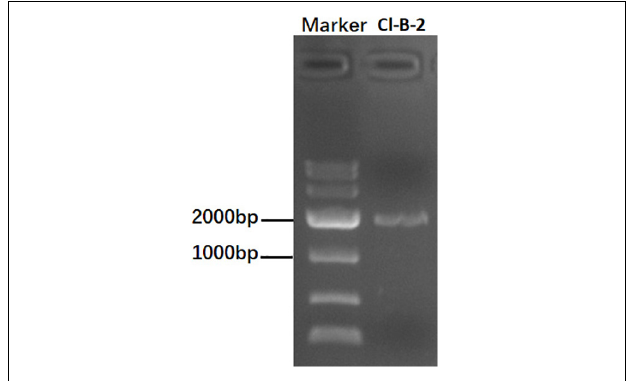
FIGURE 1 | Agarose gel electrophoresis of dsRNA extracted from the Colletotrichum liriopes strain Cl-B-2. The dsRNA extractions were treated with S1 nuclease and DNase I before being electrophoresed on 1% agar